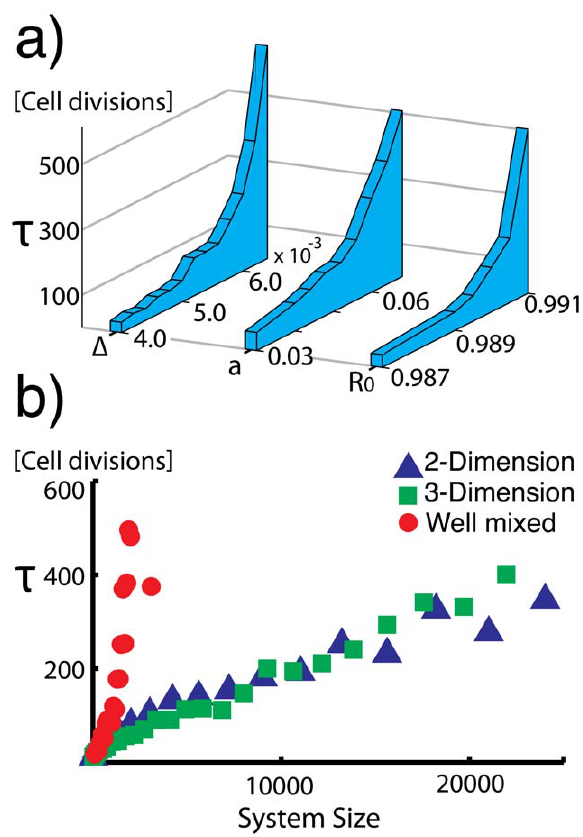
Figure 3. a) The time t spent in steady state increases with the initial repair rate R 0 , rate of apoptosis a , and fragility of the repair mechanism D . (Parameters that are not varied are set to the values given in the caption of figure 2) b) For the well mixed system, the time spent at steady state, t , increases drastically with system size N . For spatially structured systems the increase is